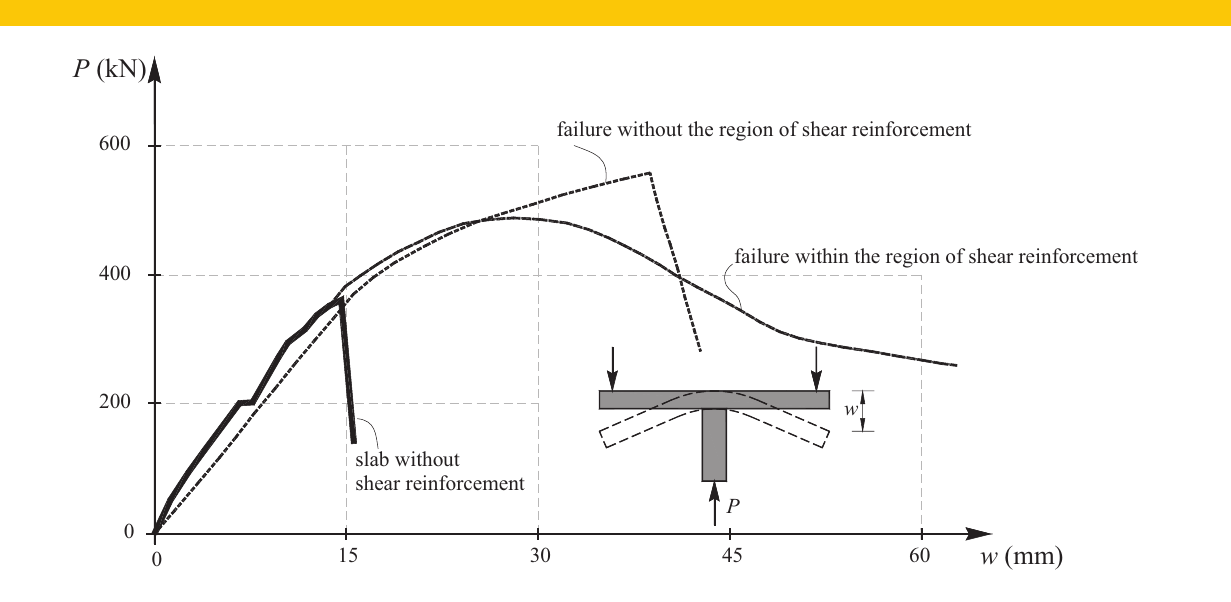
Figure 4 – Influence of the shear reinforcement in the load-displacement response - Dilger and Ghali [11]